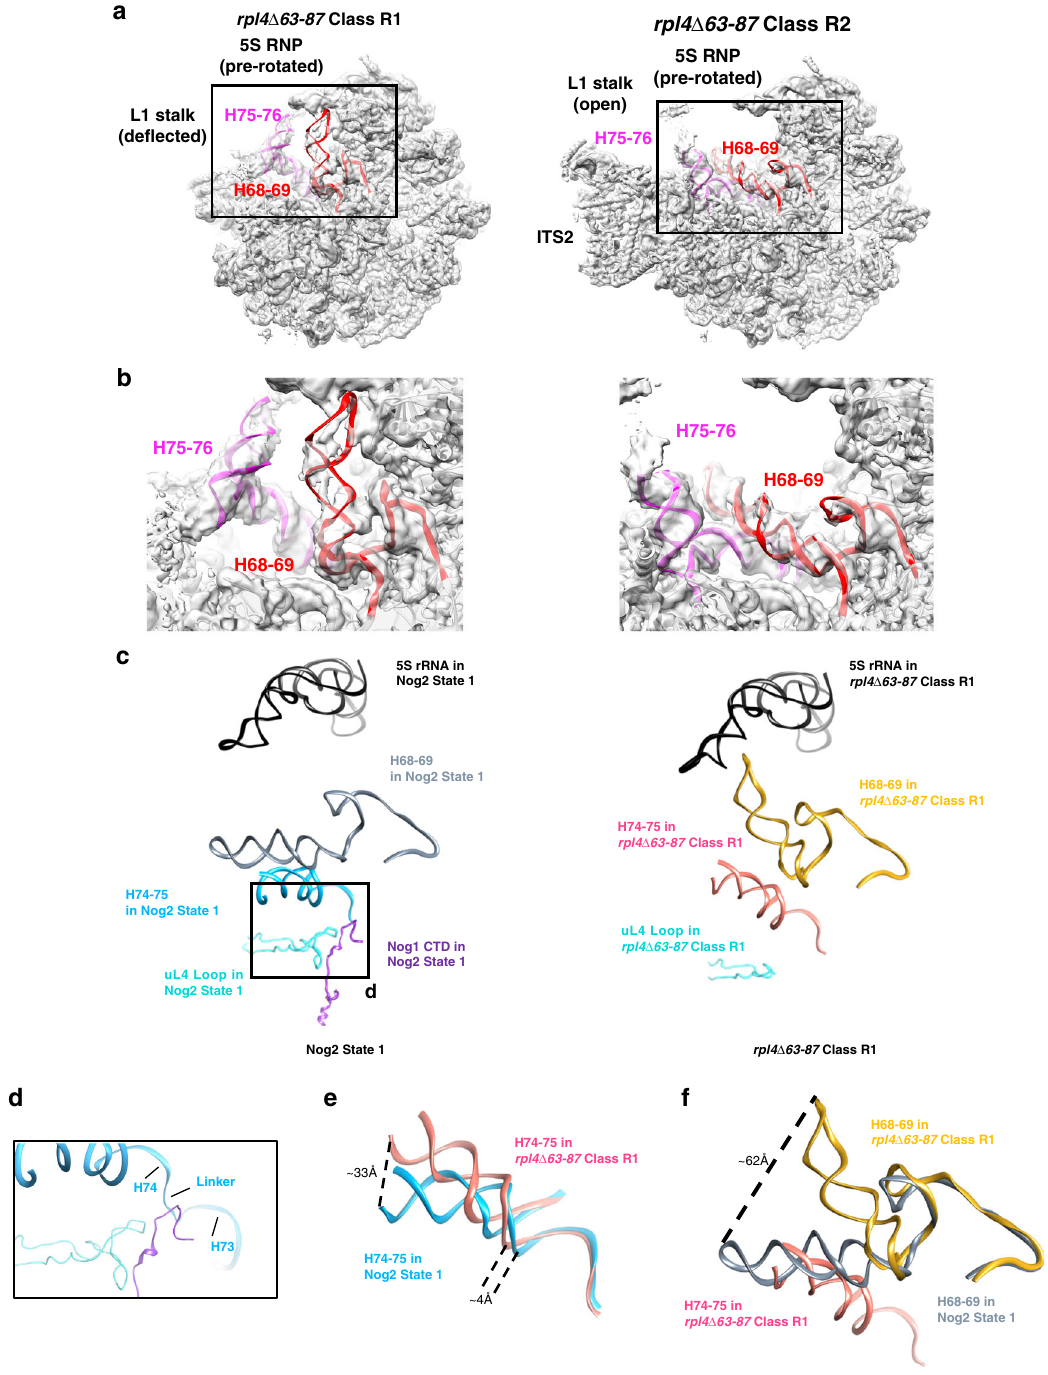
Fig. 3 Aberrant conformations of rRNA helices in rpl4 Δ 63 – 87 mutant particles. a Two major density maps (R1 and R2 particles, shown in light gray) obtained from Nog2-associated rpl4 Δ 63 – 87 particles are overlaid with their respective atomic models. b Enlarged view of the conformational changes in of rRNA helices from the two major classes of the rpl4 Δ 63 – 87 mutant. Compared with wild-type Nog2-particles (state 1), H75-76 (magenta) and H68-69 (red) have undergone dramatic conformational changes in class R1 but not in class R2. c rRNA helices from the atomic model of wild-type Nog2 state 1 particles are compared with those in the atomic model of the rpl4 Δ 63 – 87 mutant class R1. Positions of relevant rRNA helices in relation to uL4 and Nog1 in the NPET in RPL4 wild-type (left) and rpl4 Δ 63 – 87 mutant (right) Nog2 particles. Helix 74 – 75 (light blue for wild-type and hot pink for mutant) extend into the NPET. H74 is located in close proximity to the uL4 TD (cyan) and the CTD of Nog1 (dark purple). H74-75 are located below H68-69 (gray for wild-type and gold for mutant). The 5S rRNA (black) is shown to provide a frame of reference. d Inset showing the interaction of the TD of uL4, the Nog1 CTD, and the rRNA linker between H73 and H74. e H74-75 from rpl4 Δ 63 – 87 mutant particles (hot pink) are shifted relative to those in wild-type Nog2 state 1 particles (light blue). H74 is displaced up to ~4 Å while H75 is shifted up to ~33 Å. f H75 in rpl4 Δ 63 – 87 mutant particles is shifted to an aberrant position (hot pink) that clashes with the native position of H68 (gray). This displaces H68 in rpl4 Δ 63 – 87 mutant particles (gold), causing it to shift up to ~62